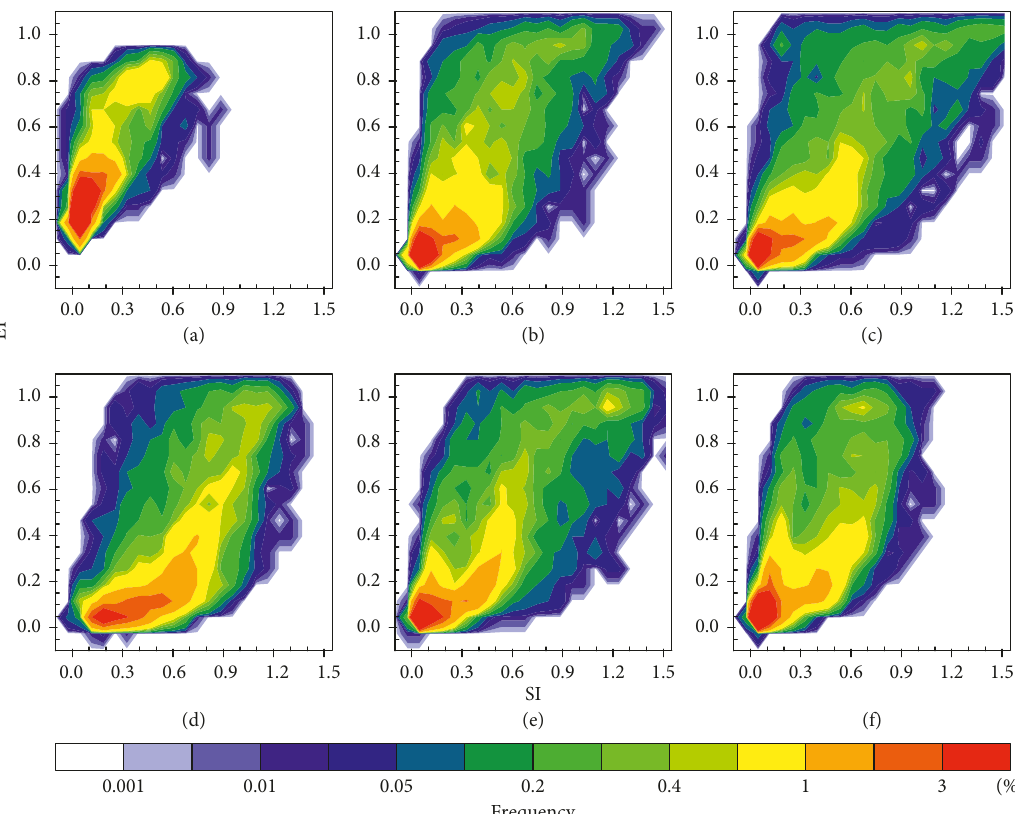
Figure 9: Joint histograms of scattering index (SI) and emission index (EI) for (a) FY-3B-MWRI and five simulations (b–f), (b) WSM6, (c) GSFC, (d) THOM, (e) MORR, and (f) NSSL, corresponding to the time of FY-3B overpasses of